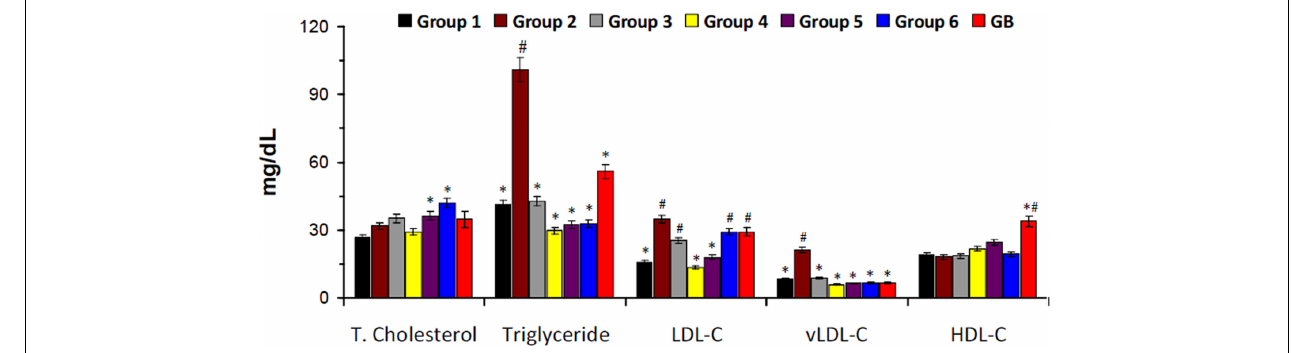
FIGURE 3 | Serum lipid profile of experimental groups. Data = mean ± SD ; n = 6. ∗ Statistically significant ( p < 0.05) compared to group 2; # statistically significant ( p < 0.05) compared to group 1. Group 1: normal control; Group 2: diabetic control; Group 3: diabetic rats + crude extract; Group 4: diabetic rats + dichloromethane fraction; Group 5: diabetic rats + butanol fraction; Group 6: diabetic rats + aqueous fraction; GB: diabetic rats +